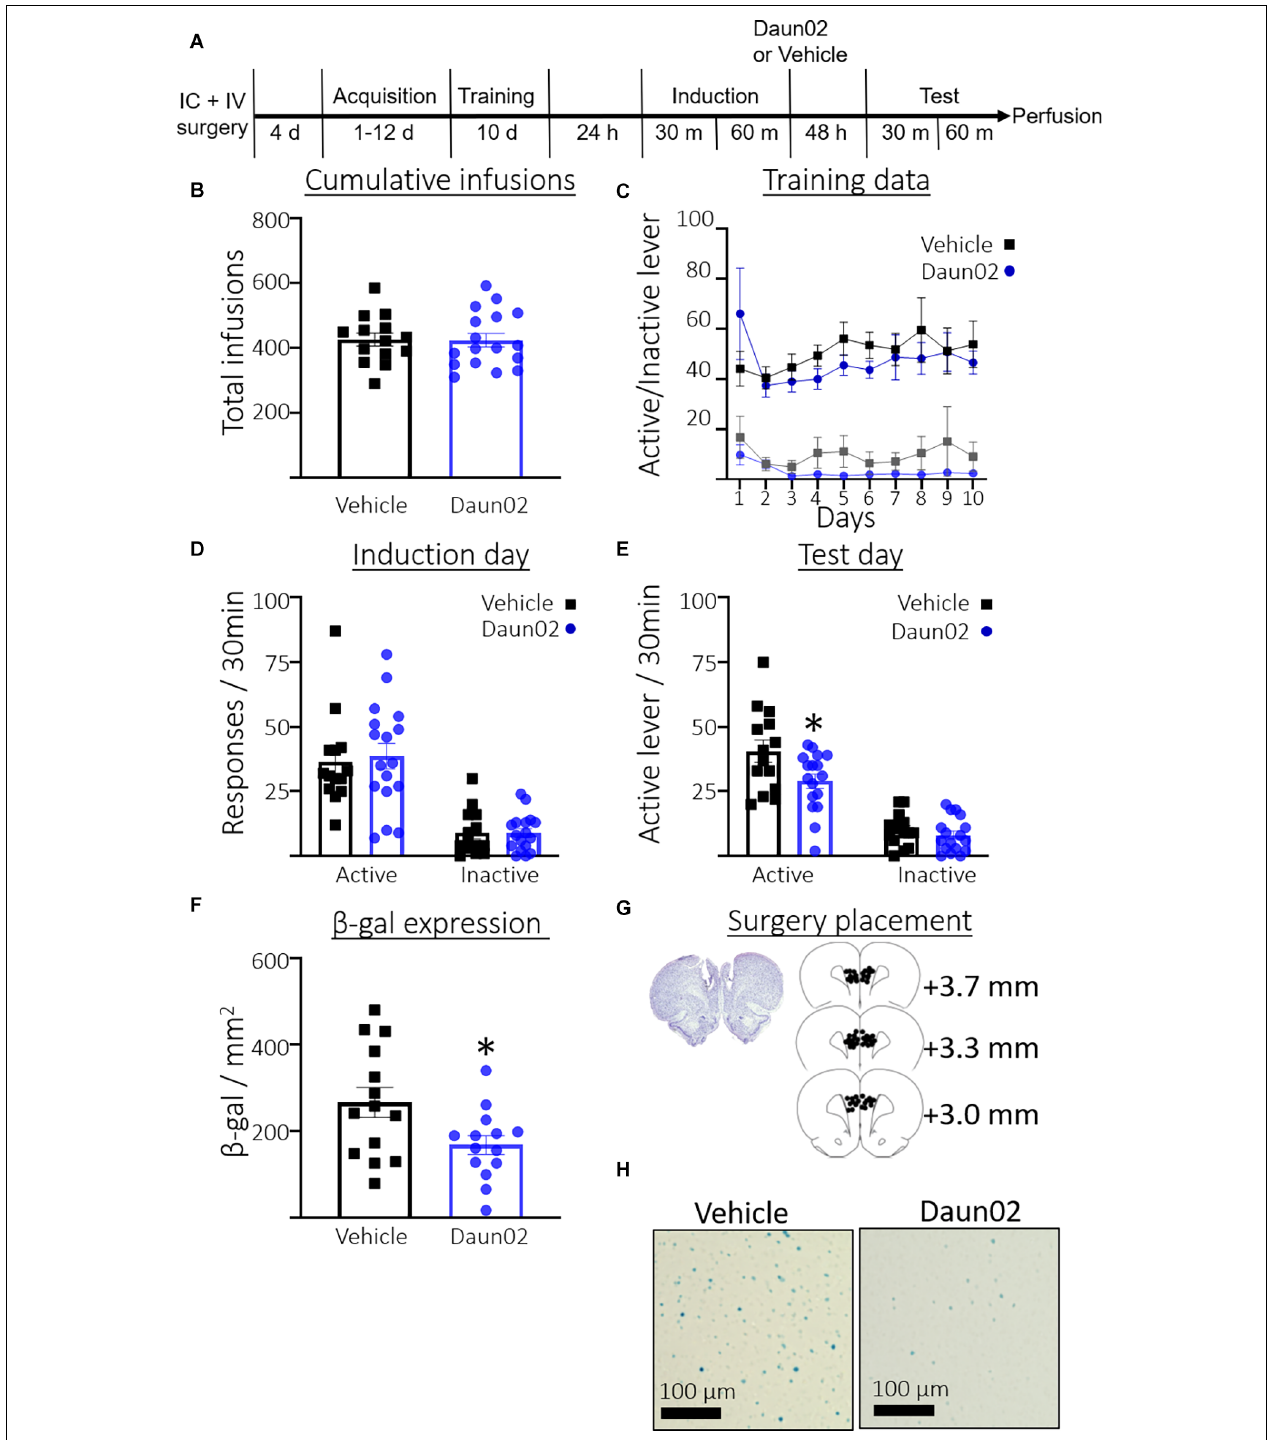
FIGURE 3 | Experiment 3: Role of PL ensembles in well-trained cocaine seeking. (A) Timeline showing the behavioral procedure. (B) The number of total infusions earned across all acquisition days and subsequent training days between rats assigned to the vehicle or Daun02 condition. (C) Active and inactive lever responses in rats assigned to the vehicle or Daun02 condition across days of training post acquisition. (D) The number of active and inactive lever responses in the induction session in rats assigned to the vehicle or Daun02 condition. (E) The number of active and inactive lever responses in the test session between rats that received either vehicle or Daun02. (F) The number of β -gal positive nuclei per mm 2 in the PL between rats that received either vehicle or Daun02. (G) Cannula placement. (H) Representative images showing β -gal labeling in the PL. Data are presented as mean ± SEM ( n = 14–17 per group). ∗ p < 0.05 compared to vehicle-treated controls.